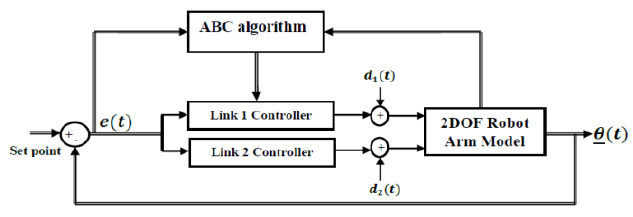
Fig. 18. Schematic of robotic system tuning in the presence of noise. The objective functions MRSE, MAE and their corresponding PID parameters are shown in Tables II and III at different values of the noise